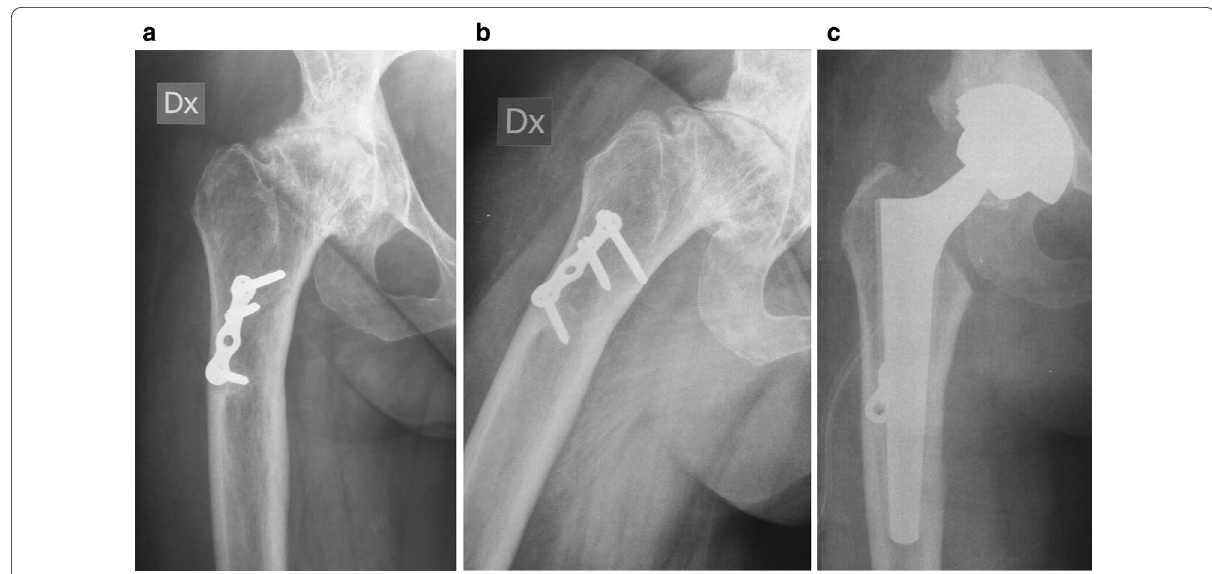
Fig. 1 a , b , Preoperative AP view of the hip and lateral view of the femur in a coxarthrosis classified as Crowe I; a femoral proximal osteotomy had been previously performed in another country. c , Postoperative AP view of the operated hip; hardware were partially left in